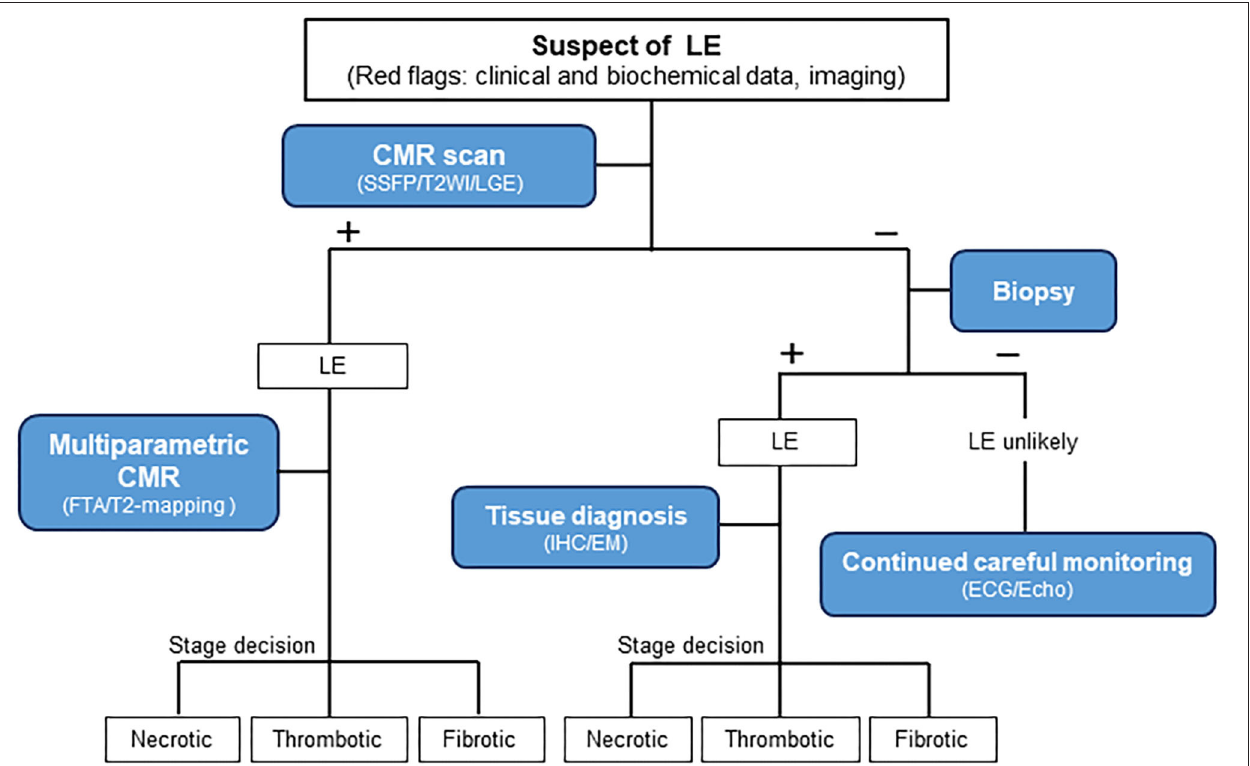
FIGURE 7 | Diagnostic algorithm for patients with suspected Löffler’s endocarditis. LE, Löffler’s endocarditis; –, negative test; + , positive test; CMR, Cardiovascular magnetic resonance; SSFP, Steady-state free precession; T2WI, T2-weighted imaging; LGE, Late gadolinium enhancement; FTA, Feature-tracking based strain analysis; IHC, Immunohistochemistry; EM, Electron microscopy; ECG, Electrocardiogram; Echo, Echocardiography.